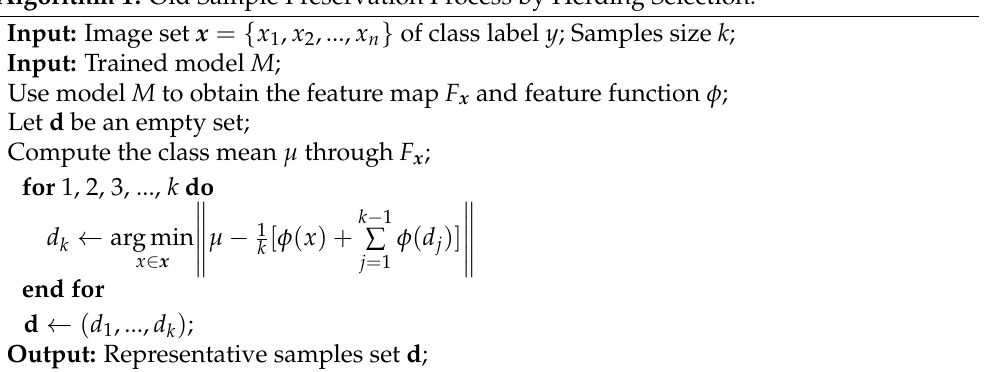
Algorithm 1: Old Sample Preservation Process by Herding